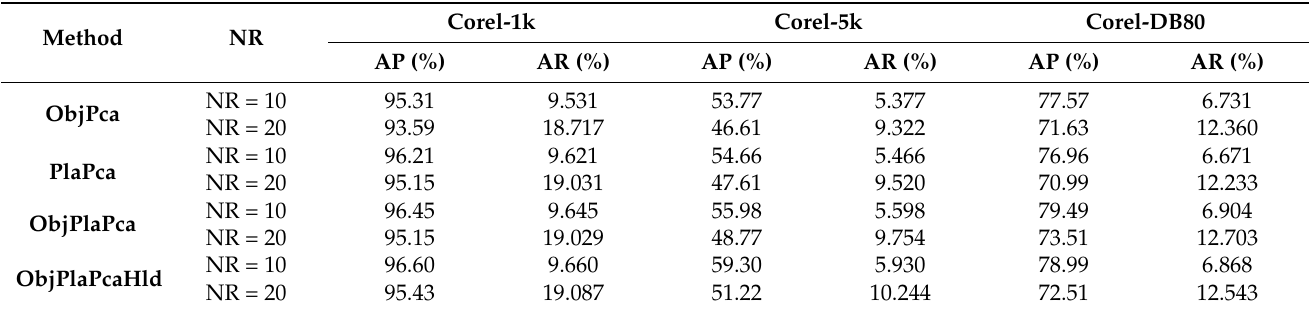
Table 10. APs/ARs of PCA-based method on three